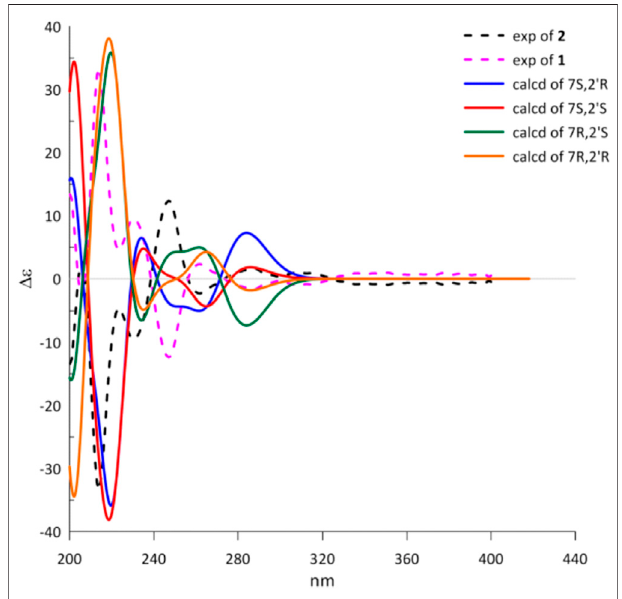
FIGURE 3 | Experimental and calculated ECD spectra of 1 and 2 .